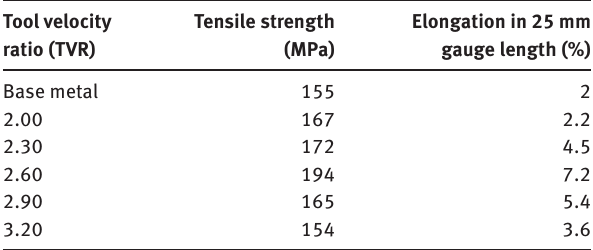
Table 6: Effect of TVR on tensile properties of FSPed material.